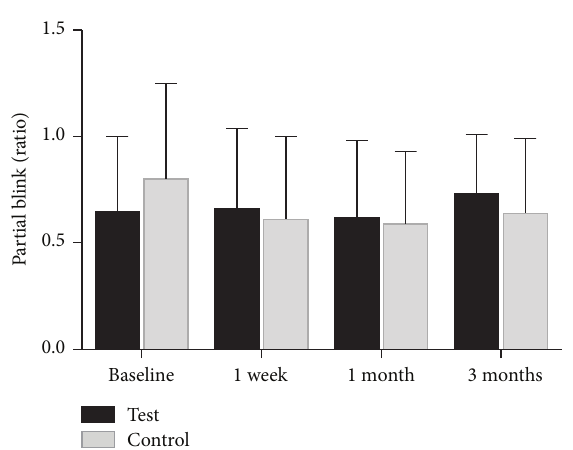
Figure 4: The mean value of test-eye partial blink (PB) ratios at baseline, at one week, at one month, and at three months.